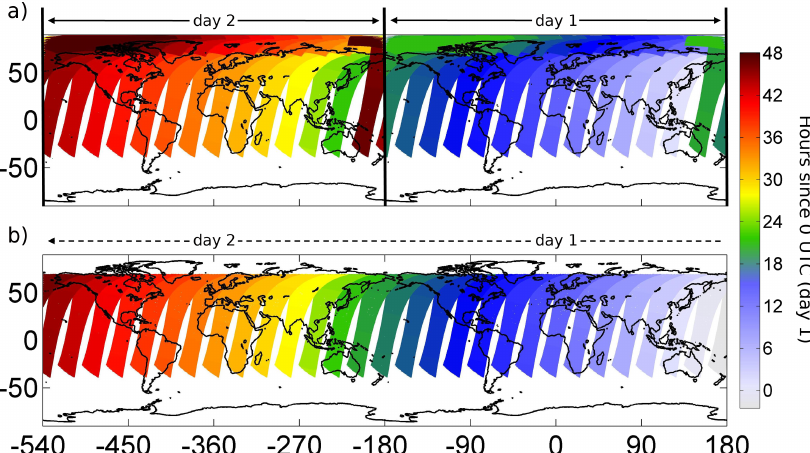
Fig. 2. (a) Two consecutive daily maps of GOME-2 satellite orbits as widely used in the scientific community (right: day 1, left: day 2). Due to an overlap of the first and the last orbit during one regarded day (area between light blue and green orbit for day 1 and green and dark red orbits during day 2), a temporal discontinuity of up to more than 24h occurs. Additionally, overlapping pixels at high latitudes show a time shift of up to ∼ 10h and another time shift of ∼ 24 h occurs at the intersecting region between day 1 and day 2. (b) Alternative global map layout for the maps with two days coverage. The chronology of satellite orbits in direct succession is now conserved in westerly direction. Measurements at more than ± 70 ◦ N and neighbouring pixels with a time shift > 3.5h are also filtered out. Table 1. Areas where the GOME-2 data were excluded for the automatic detection of volcanic SO 2 plumes. The first three areas are affected by anthropogenic emissions of SO 2 , whereas erroneous signals are detected over large parts of South America, where the deformation of Earth’s magnetic field allows cosmic high-energy particles to create false signals in the detector of the satellite instrument (South Atlantic